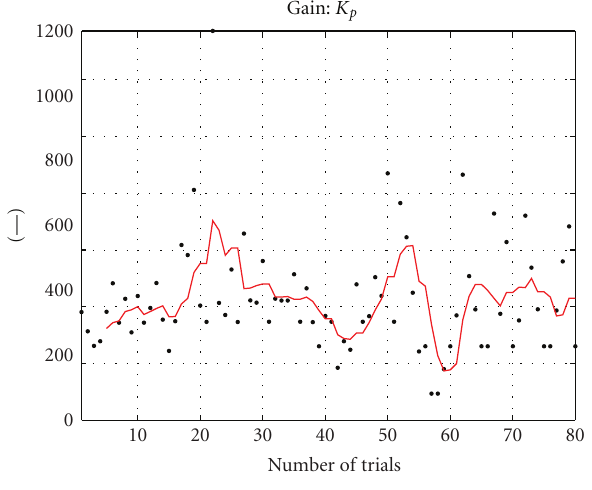
Figure 15: Change of identified K p .